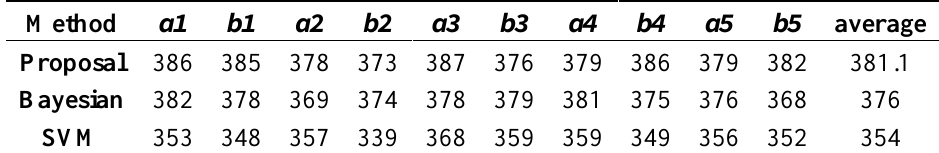
Table 3. Colum ai represents the number of elements correctly classified of ai training with bi and column bi the number of elements correctly classified of bi training with ai , i is the repetition.